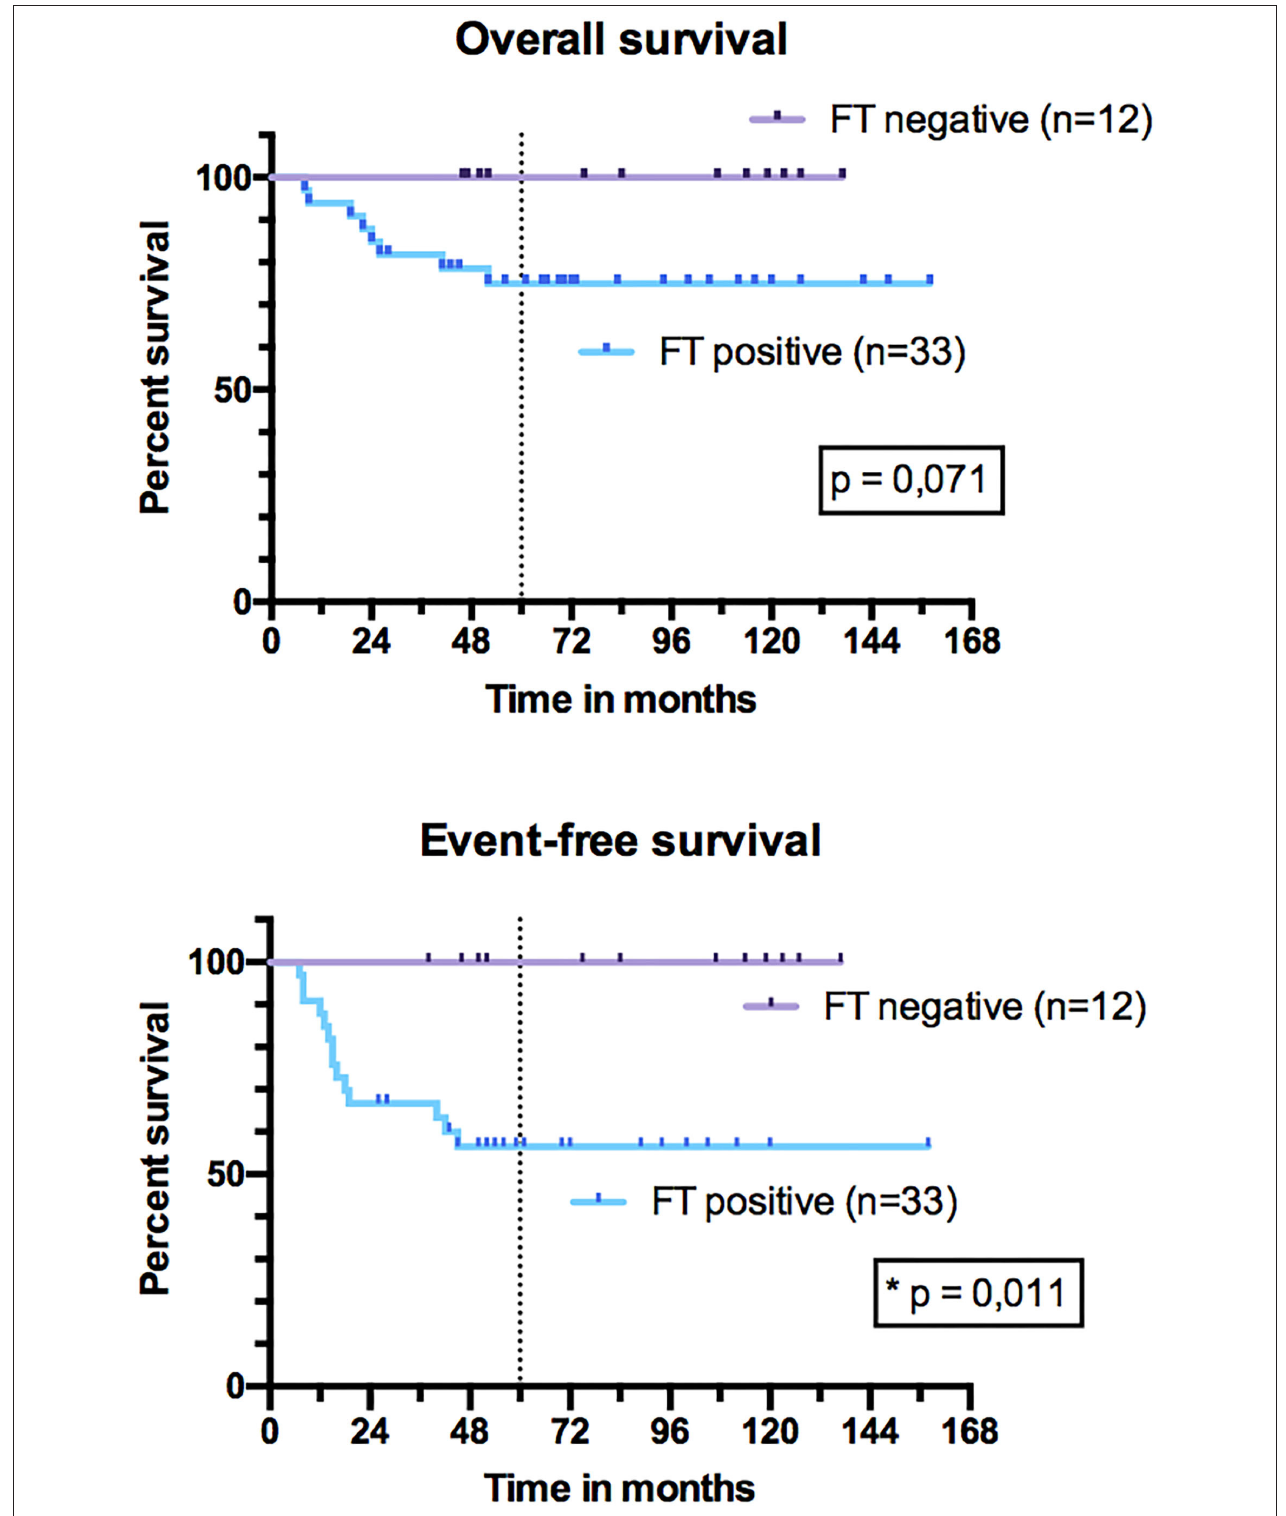
FIGURE 8 | Overall survival and event-free survival of patients with fusion transcript (FT) expression and without FT expression.